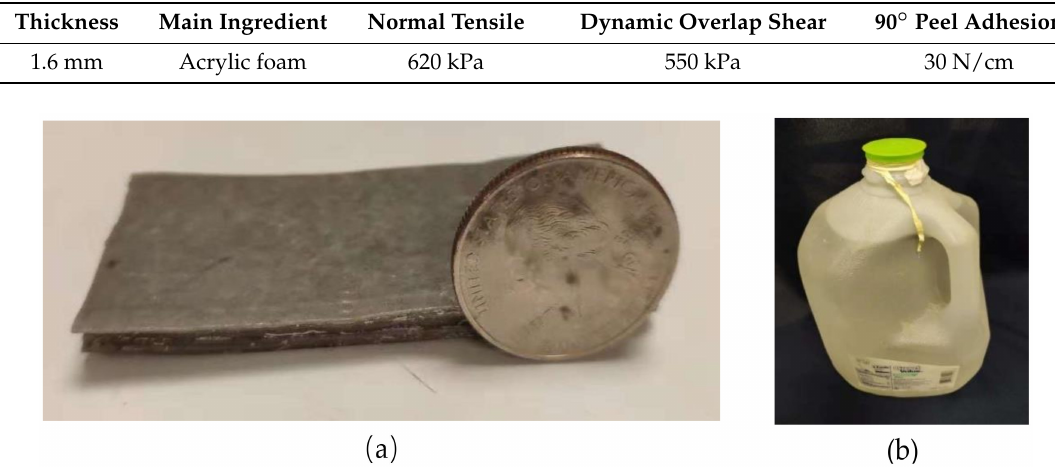
Figure 2. Specimen preparation: ( a ) viscoelastic sample; ( b ) samples in seawater.